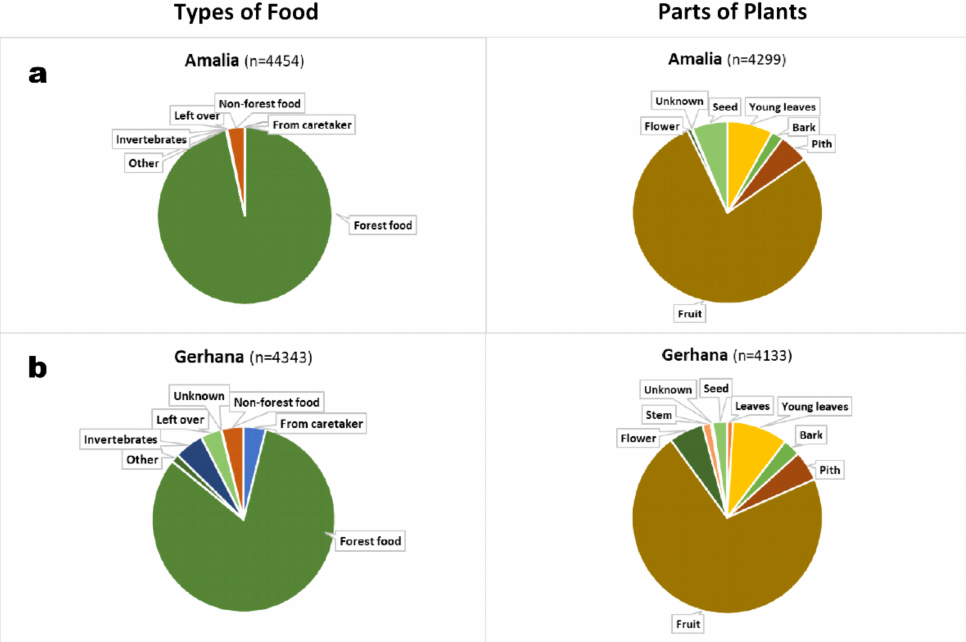
Figure 10. Types of food eaten (left) and plant organs consumed (right) by ( a ) the oldest rehabilitant Amalia (8–9 years), and ( b ) the youngest, Gerhana (19–37